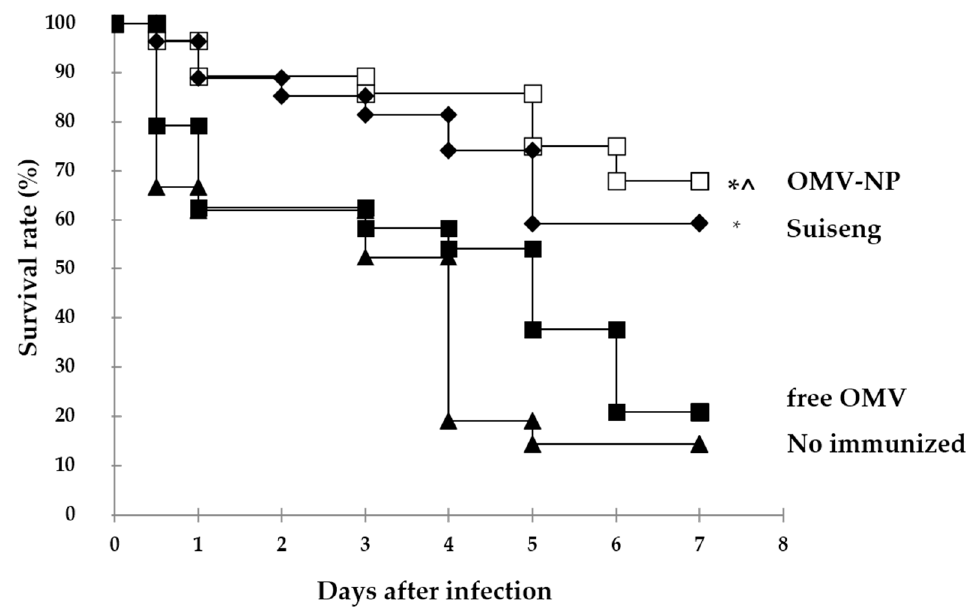
Figure 8. E ff ect of active immunization on the protection against F4-ETEC infection of BALB / c mice pups from mothers immunized with OMV encapsulated into nanoparticles. Two-week-pregnant BALB / c mice were immunized orally with a single dose of OMV (0.2 mg) either free or encapsulated into nanoparticles (OMV-NP) or intraperitoneally with the commercial vaccines (Suiseng ® , Lab. Hipra). One week after birth, the pups were infected orally with a single dose of F4 E. coli ETEC (1.2 × 10 8 CFU / mouse) resuspended in 100 µ L PBS. Graphs indicate the percentage of mice that survived the infective challenge at the indicated days after immunization (*, p < 0.01, for immunized mice vs. control; ˆ p < 0.05 OMV-NP vs. free